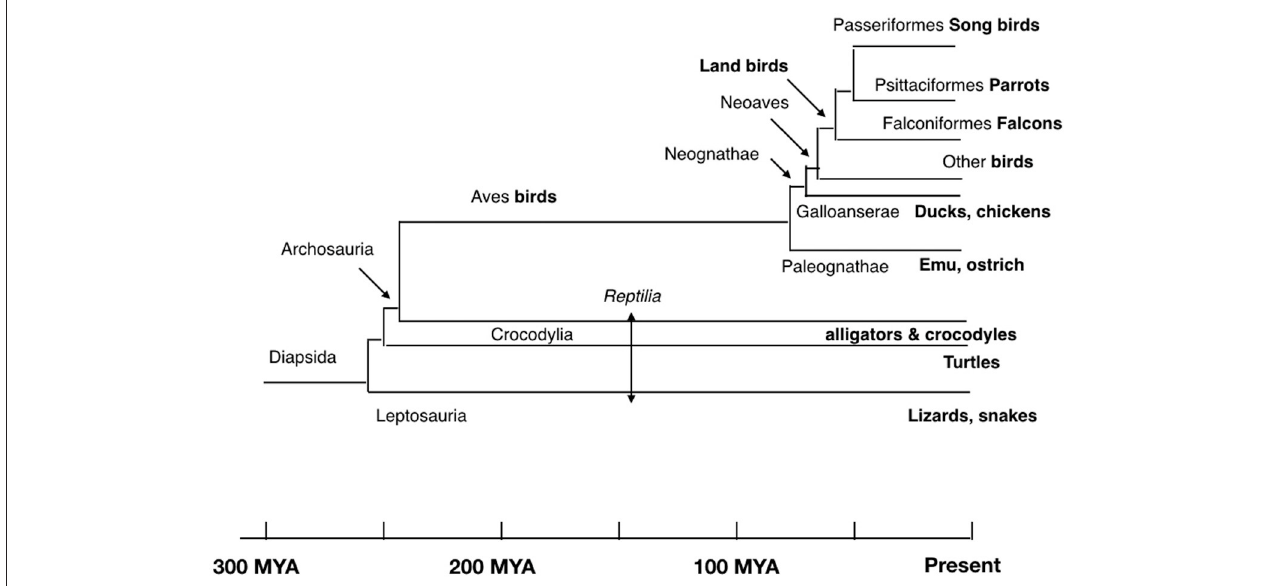
FIGURE 4 | Evolutionary relationships of birds and reptiles showing conjectural time line (based on Hedges and Kumar, 2009; Chiari et al., 2012; Ezcurra et al.,